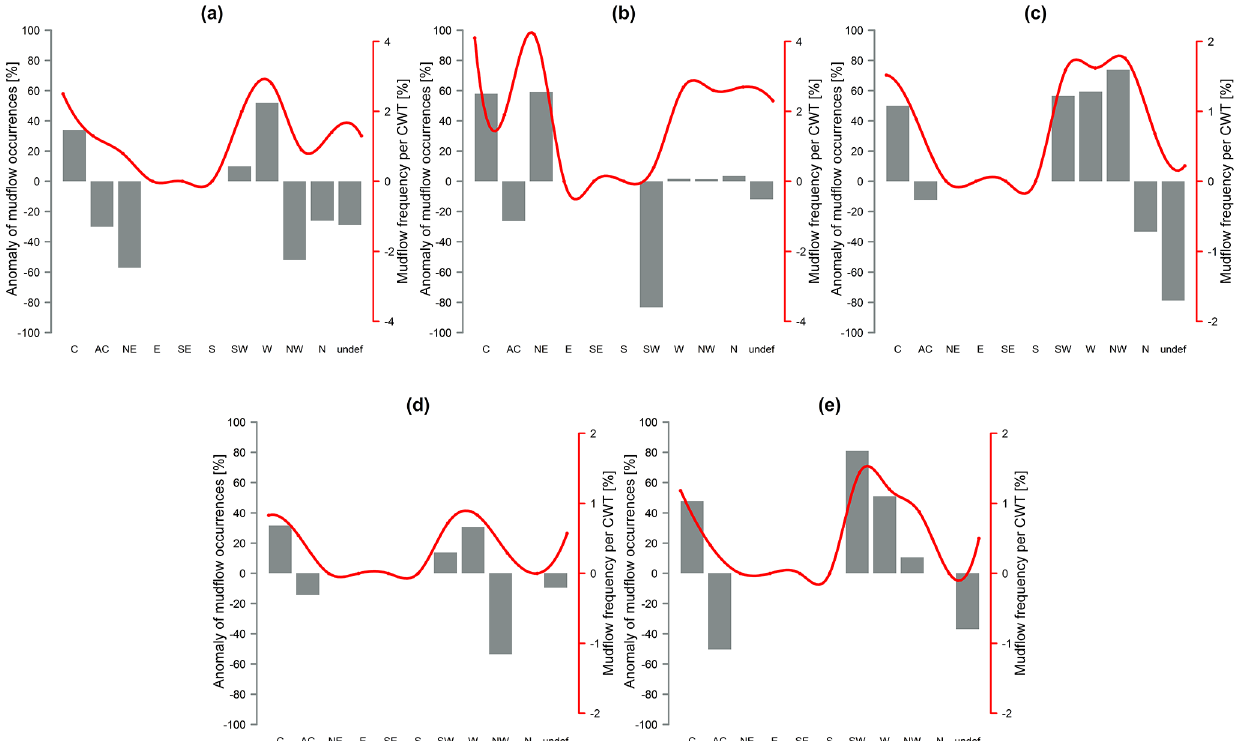
Figure 13. Anomaly of mudflow days for every CWT class (grey bars, grey axis, %) and CWT classes for mudflow days (red line, red axis, %) for the March–August period between 1984 and 2013 in five regions: (a) Zerafshan basin (101 days), (b) Fergana Valley (147 days), (c) Chirchik–Akhangaran river basin (57 days), (d) Kashkadar’ya basin (35 days), (e) Surkhandar’ya basin (44 days). The panels have different scales.